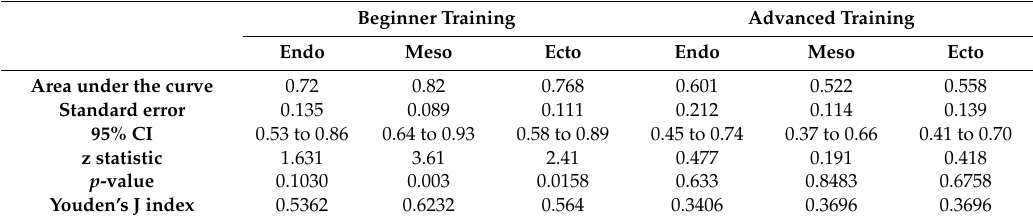
Table 4. Characteristics of the ROC curves for somatotype components in the beginner training and advanced training groups.